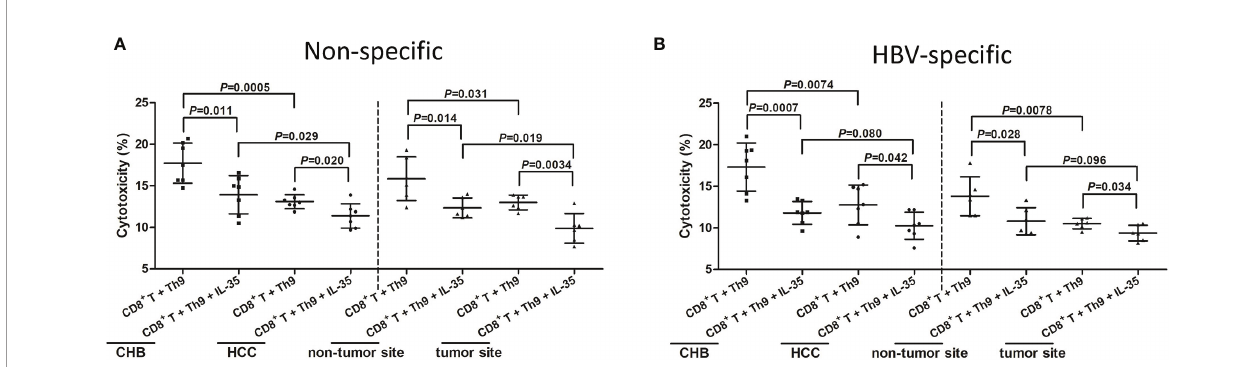
FIGURE 7 | In fl uence of recombinant IL-35 to Th9-induced CD8 + T cell cytotoxicity in hepatitis B-related hepatocellular carcinoma (HCC). CD4 + CXCR3 - CCR4 - CCR6 - cells were puri fi ed from peripheral blood mononuclear cells (PBMCs) of chronic hepatitis B (CHB) patients ( n =7) and hepatitis B-related HCC patients ( n =7), as well as from intrahepatic lymphocytes (IHLs) of fresh HCC specimens and non-tumor site liver specimens in HCC patients ( n =6). CD4 + CXCR3 - CCR4 - CCR6 - Th9 cells were stimulated with anti-CD3/CD28 (1 m g/mL) or HBsAg (10 m g/mL) in the presence or absence of recombinant IL-35 (1 ng/mL) for 24 hours. 10 4 of stimulated Th9 cells were co-cultured with 10 4 of autologous CD8 + T cells in a direct contact manner with 10 5 of HepG2.2.15 cells in the presence of anti-CD3/ CD28 (1 m g/mL) or HBV core 18-27 peptide (5 m g/mL). Supernatants were harvested 48 hours post co-culture. (A) Percentage of target HepG2.2.15 cell death was measured by LDH release, and was compared among groups with or without IL-35 stimulation in non-speci fi c manners. Signi fi cance was assessed using one-way ANOVA and SNK- q test. (B) Percentage of target HepG2.2.15 cell death was measured by LDH release, and was compared among groups with or without IL-35 stimulation in HBV-speci fi c manners. Signi fi cance was assessed using one-way ANOVA and SNK- q